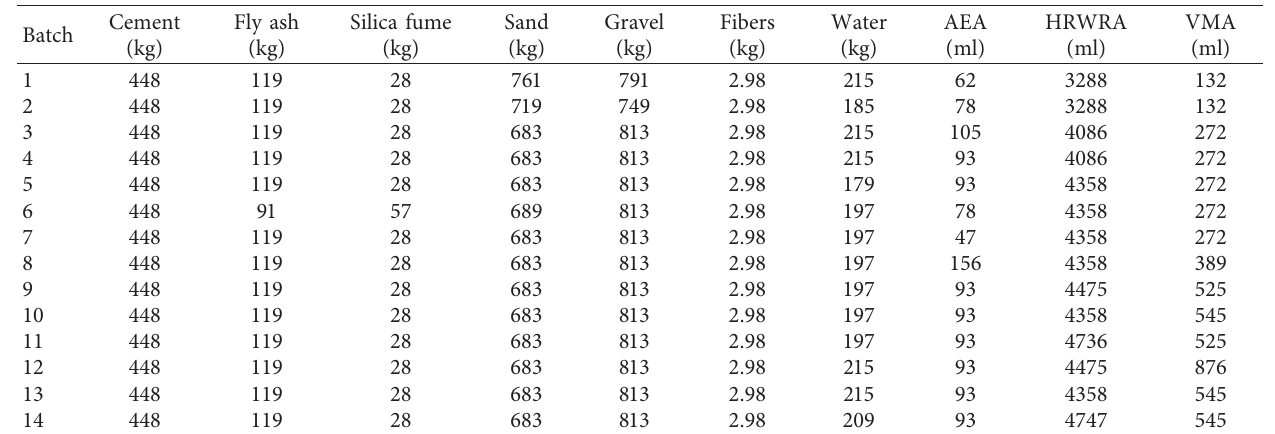
Table 2: Material proportions for FRSCC